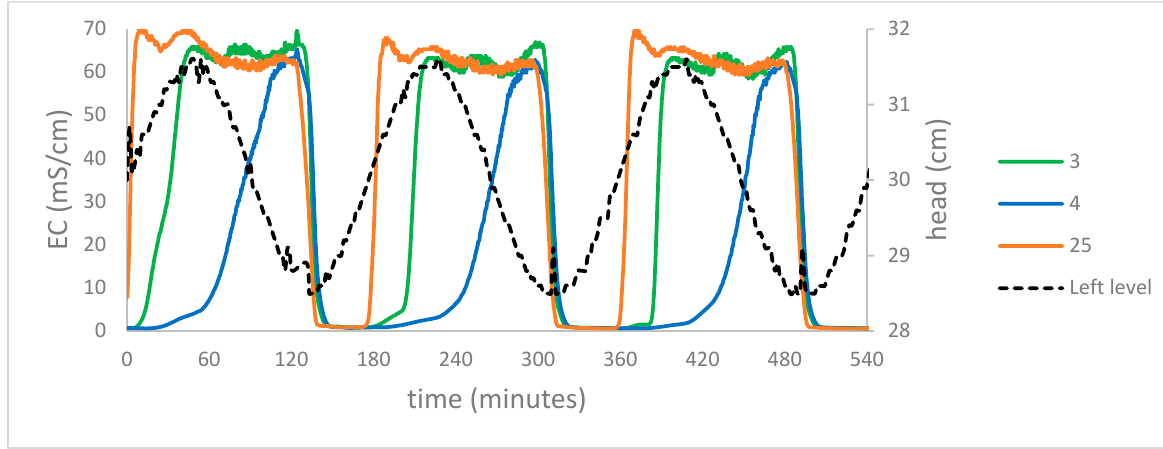
Figure 3. Left level head boundary conditions and water electrical conductivity at three sensors during E3-180. Sensor locations are shown in Figure 2a.